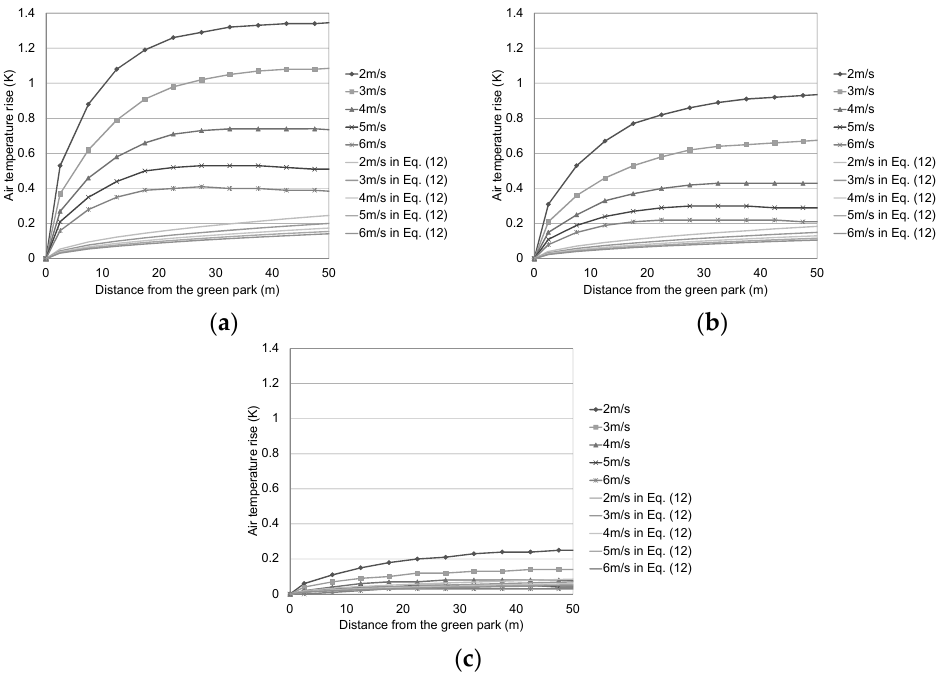
Figure 12. Air temperature rise by Equation (12). In the cases where the sensible heat flux is ( a ) 236.7 W/m 2 ; ( b ) 132.5 W/m 2 ; ( c ) 28.3 W/m 2 .